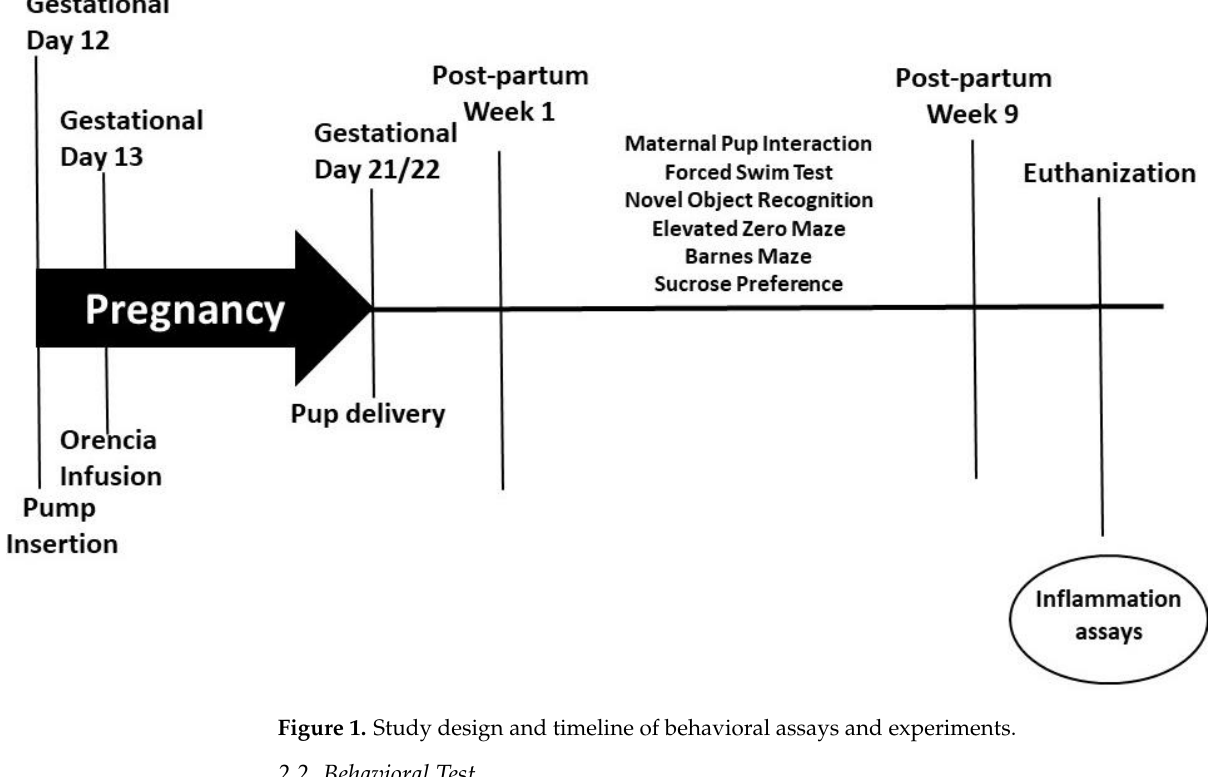
Figure 1. Study design and timeline of behavioral assays and experiments.